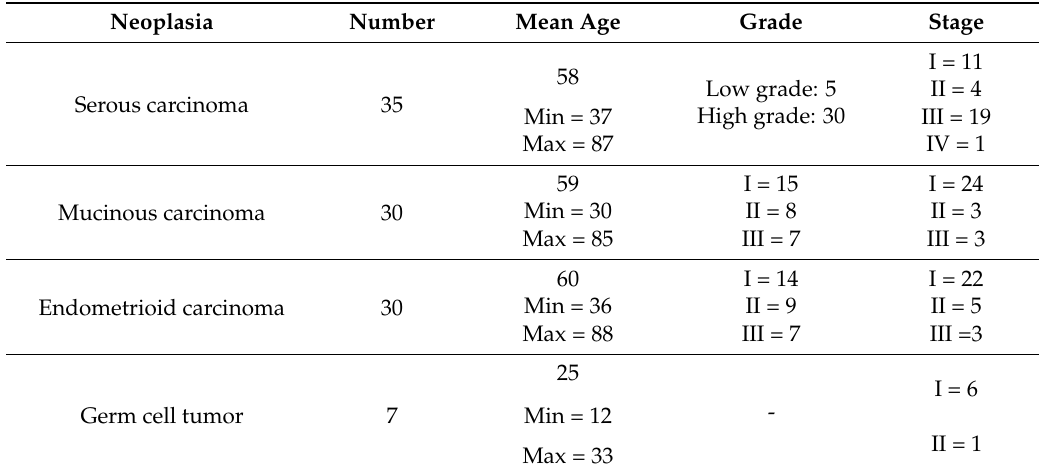
Table 1. Clinical and pathological features of patients with ovarian